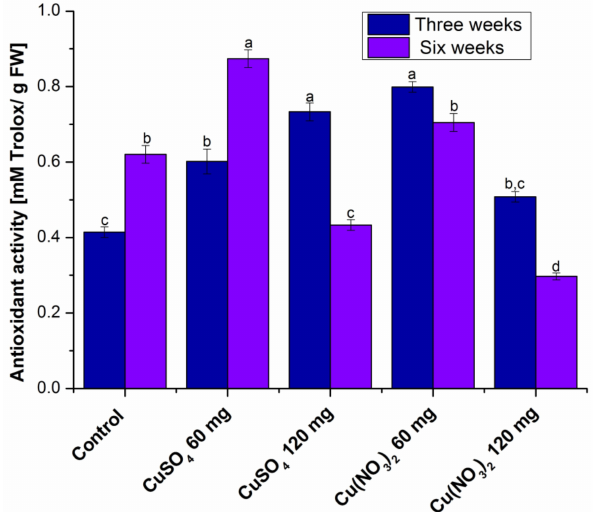
Figure 3. The antioxidant activity (DPPH) of the analyzed extracts. Each data point is the mean ± the standard error of the mean of three independent replicates experiments; different letters mean significant differences between the treatment and the control plants, determined by Tukey’s test ( p <